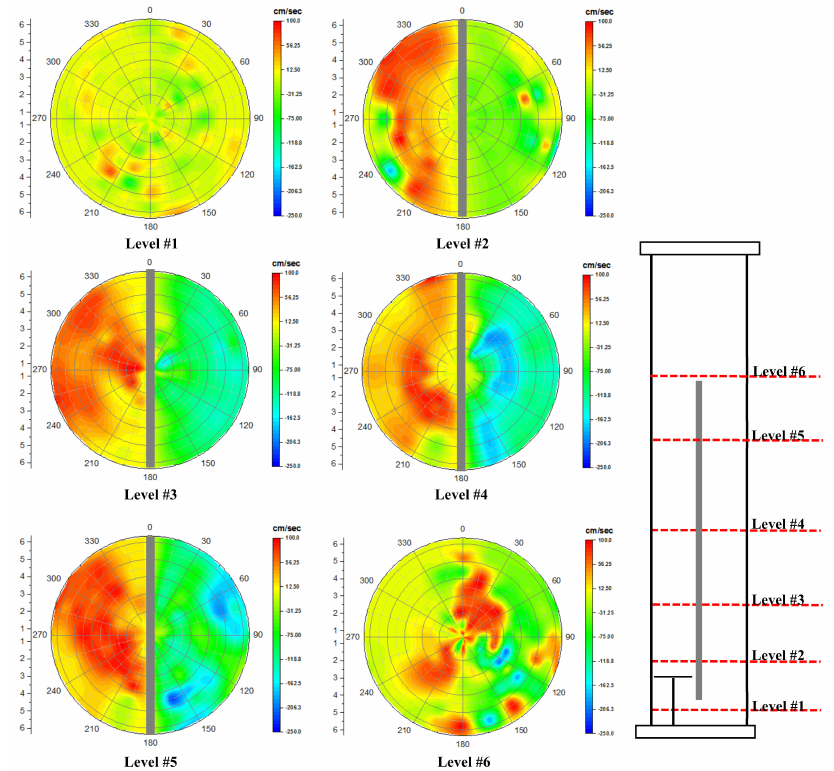
Figure 12. Cross-sectional distributions of axial liquid velocity at different heights of split airlift reactor operated under gas velocity of 1 cm/s.